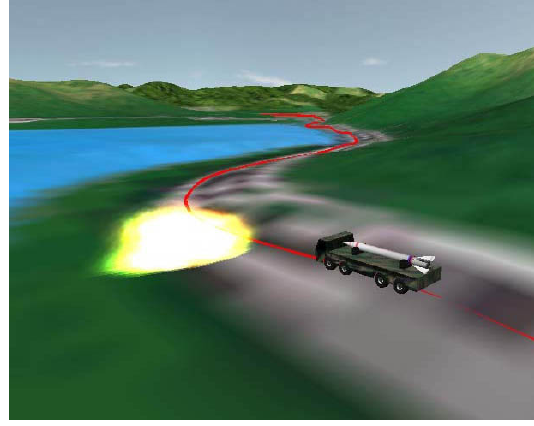
Figure 6b. moving object on ground Figure 6. Modeling and Visualization of moving objects on